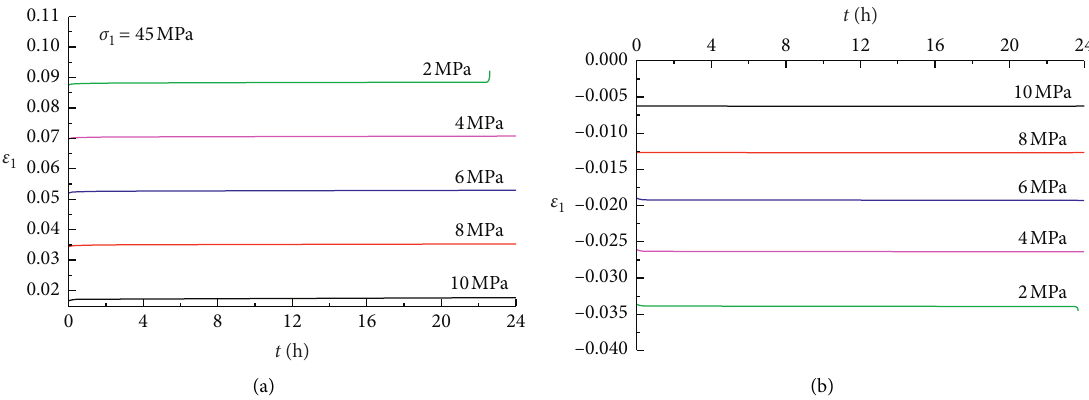
Figure 4: Unloading rheological curve cluster of the complete coal sample. (a) Cluster of axial creep curves. (b) Cluster of lateral creep curves.